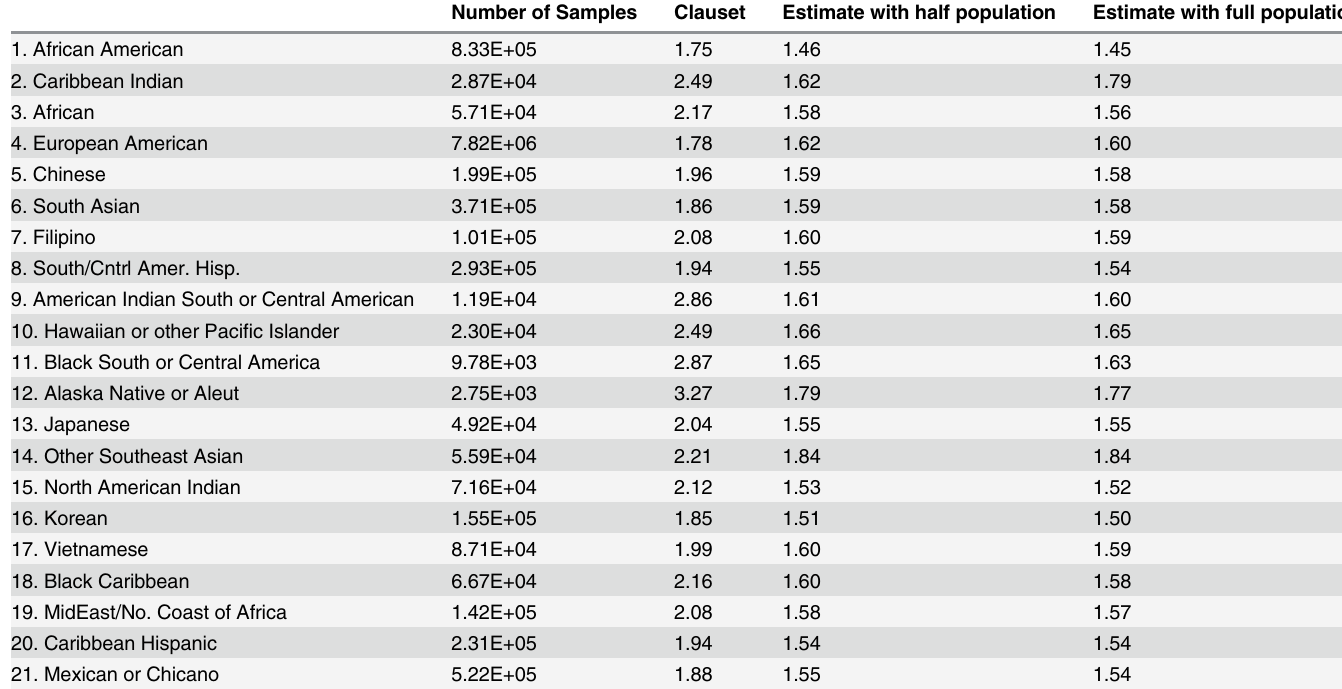
Table 3. The values of α obtained from the 21 detailed US populations studied